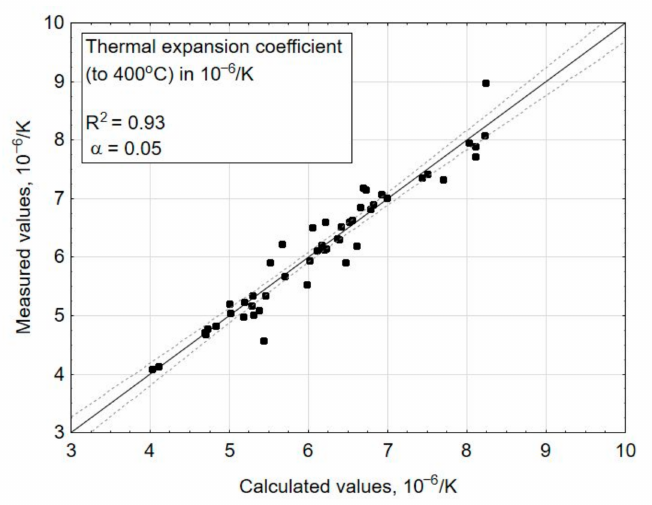
Figure 5. Comparison of the measured values (experimentally tested) and the estimated values (calculated using the chosen mathematical model)—for a dependent variable: thermal expansion coefficient α , in 10 − 6